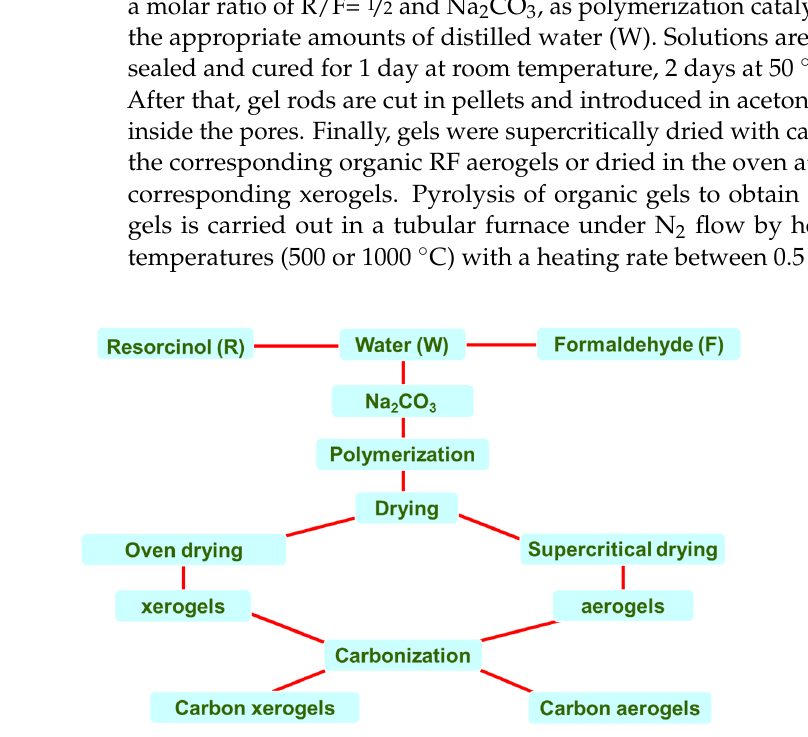
Figure 7. Sequence followed for the preparation of carbon-gel supports.